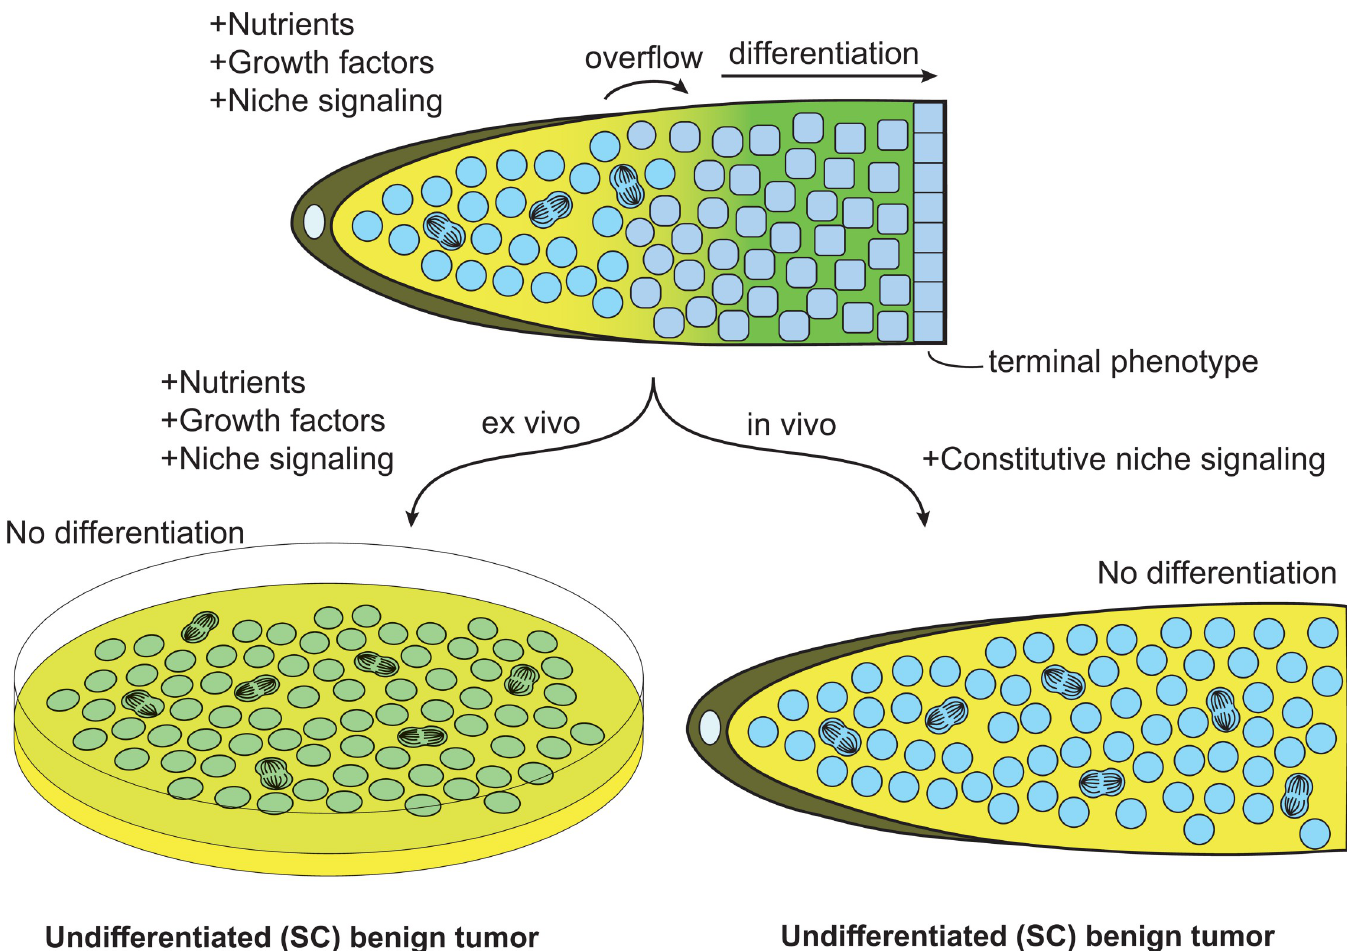
Fig 3. Undifferentiated SC tumors in vitro and in vivo. Top, graphical representation of a simple in vivo SC system or tissue. Left, extracted SCs grown in vitro form an ever-expanding undifferentiated benign tumor. Right, in vivo, undifferentiated benign tumors can occur when a mutation constitutively activates niche signaling. SC, stem